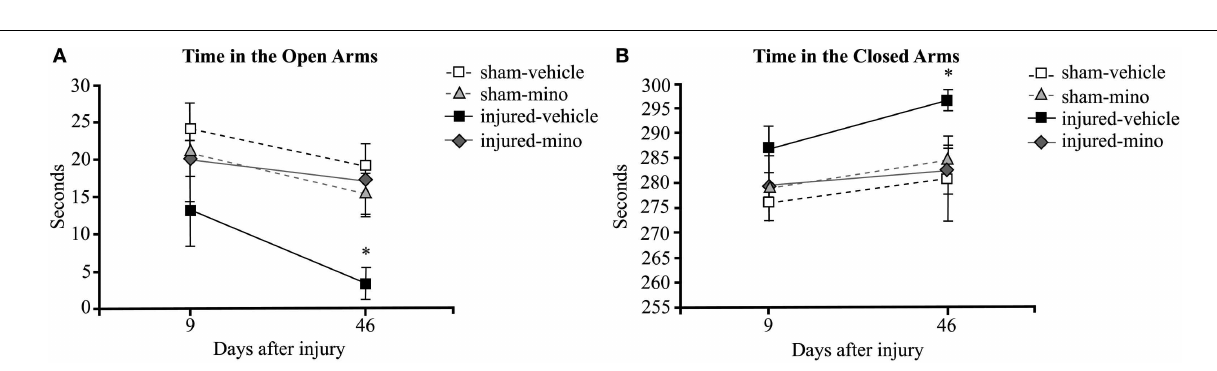
FIGURE 1 |The effect of injury and minocycline treatment on basic locomotor activities at different time points after mbTBI. (A) Horizontal activity (number of beam breaks), and (B) Resting time (seconds) were measured in Open field. Data are presented as mean ± SEM. * p < 0.05 for injured-vehicle vs. sham-mino rats.